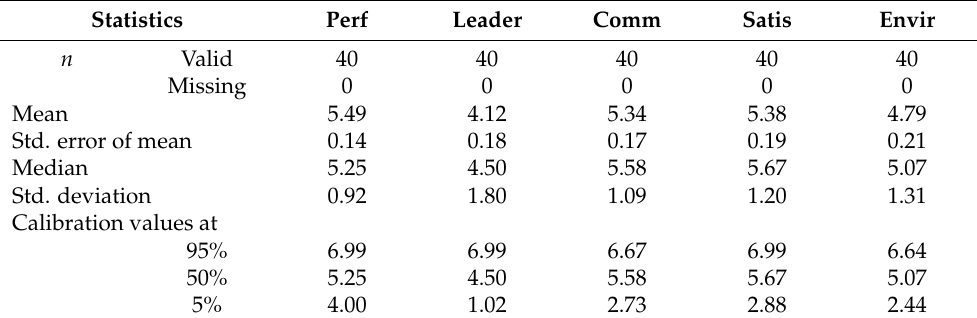
Table 2. Summary data for job performance, leadership, organizational commitment, job satisfaction, and work environment study.